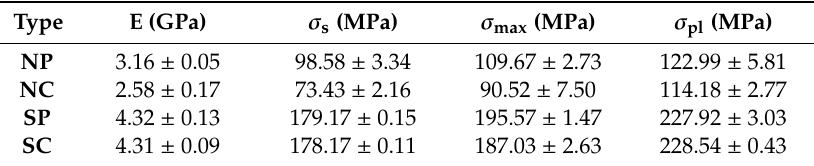
Table 4. Mechanical properties of di ff erent types of